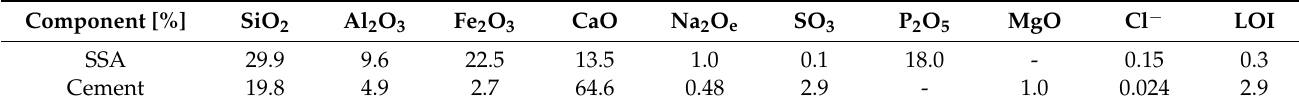
Table 1. Chemical composition of SSA with the used CEM I 42.5R